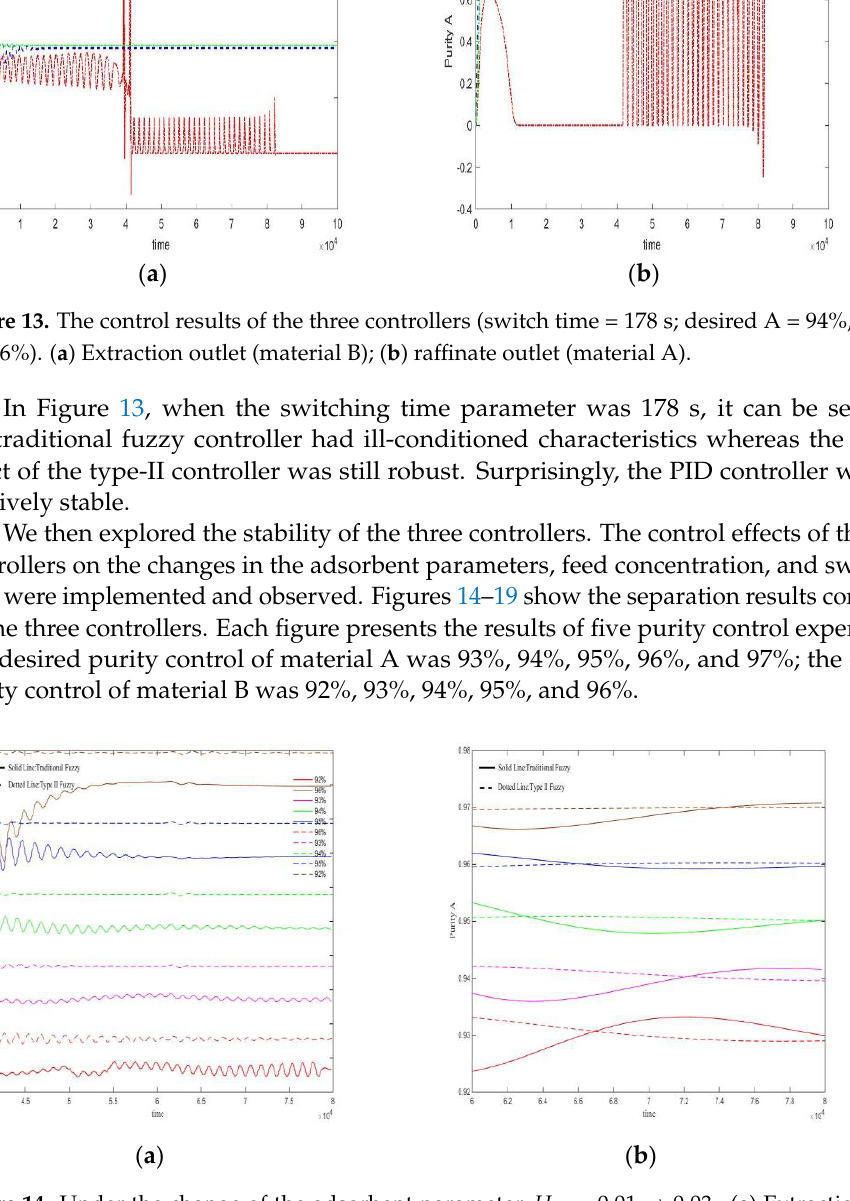
( a ) ( b ) Figure 15. Under the change of the feed port concentration . ( a ) E x traction outlet (material B); ( b ) raffinate outlet (material A). ( a ) ( b ) Figure 16. Under the change of the switch time . ( a ) Extraction outlet (material B); ( b ) raffinate outlet (material A).